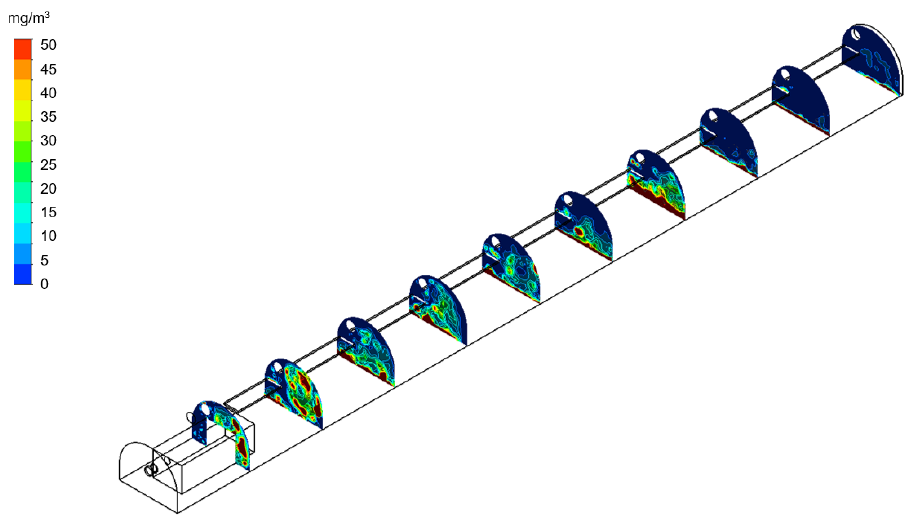
Figure 8. Mass dust concentration in the dog heading for time analysis t = 180 s for total dust rate = 0.00075 kg/s.